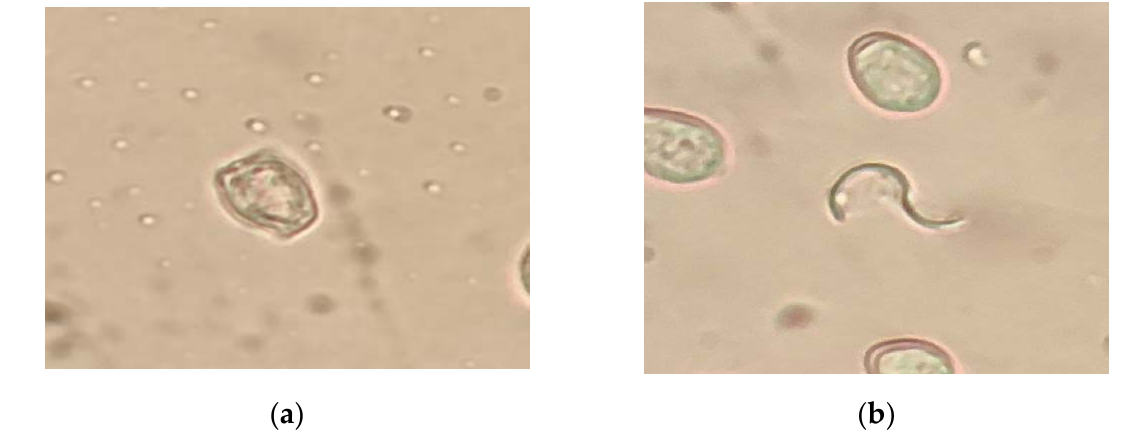
Figure 3. Cells with partially damaged membranes ( a ) and completely damaged cells ( b ) at 15 W/m 2 and a contact time of 20 min (×600 magnification).